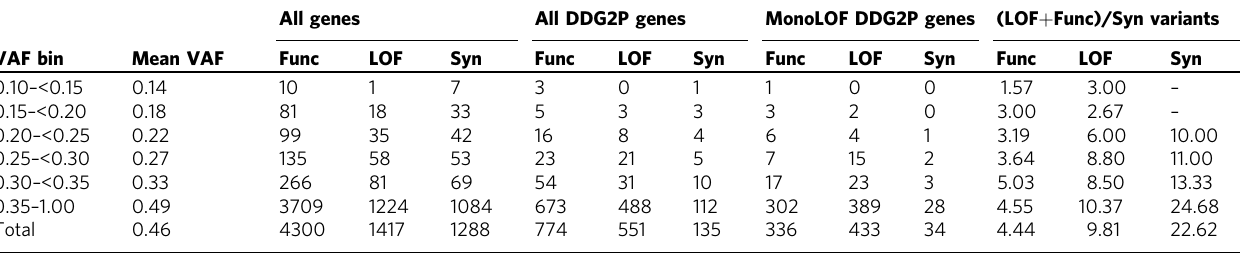
Table 2 Summary of candidate DNMs observed in 4293 DDD trios, sub-divided by variant allele fraction, variant consequence and gene class. Note this table includes all candidate DNMs; it is not limited to those with validation data, and thus includes some likely false positives particularly at lower